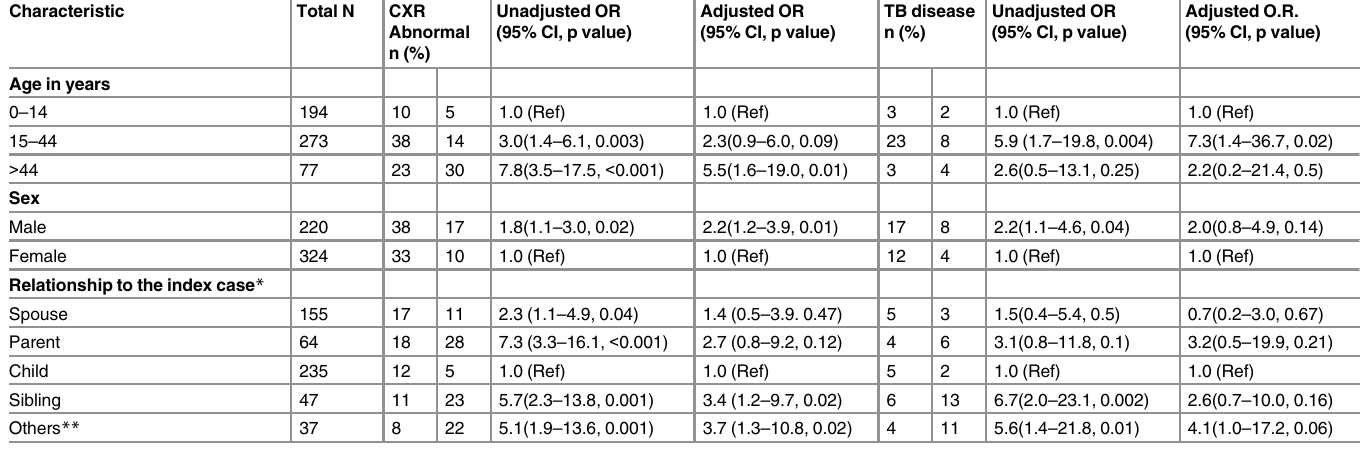
Table 3. Factors associated with abnormal CXR and TB disease among the household contacts who had their CXR done (N = 544) in Chennai, India. Characteristic